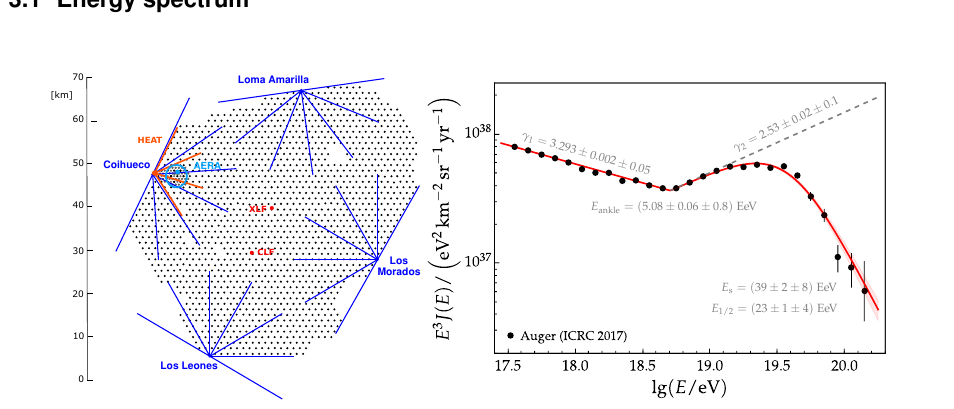
Figure 1. Left: layout of the Pierre Auger Observatory: black dots indicate WCD positions, blue and orange lines show the azimuthal field of view of the fluorescence telescopes [2]. Right: the combined energy spectrum and the fitting function with the fitting parameters